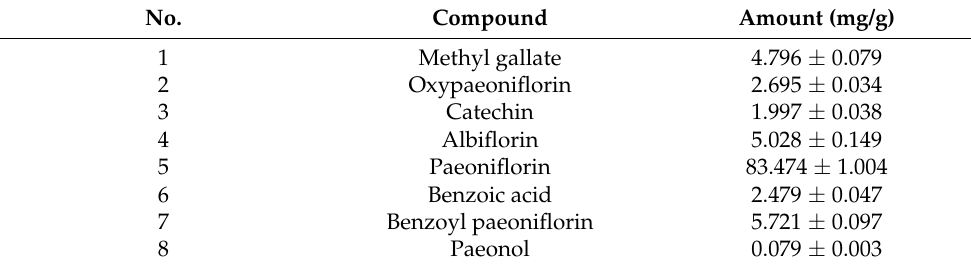
Figure 3. HPLC-UV (240 nm) profile of Paeonia lactiflora extract (PLE). ( A , B ) HPLC chromatogram of PLE. ( C ) HPLC chromatogram of PLE reference standards monitored at the wavelength of 240 nm. The identities of the compounds are as in Table 2 and the structures are in ( A ). Table 2. Individual compounds in root Paeonia lactiflora